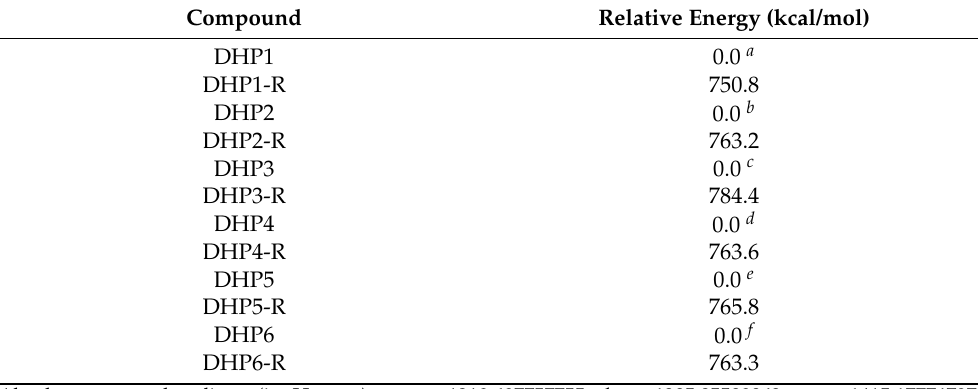
Absolute energy baselines (in